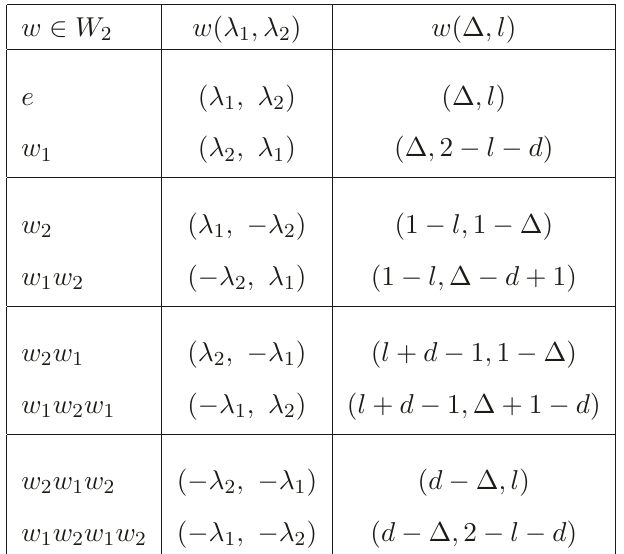
Table 1 . Elements of the Weyl group W 2 for the BC 2 root system (first column) along with their action on the asymptotic data λ = ( λ 1 , λ 2 ) (second column). The third column is identical to the second, but uses a different parametrization of the asymptotic data that we will discuss in section 4.